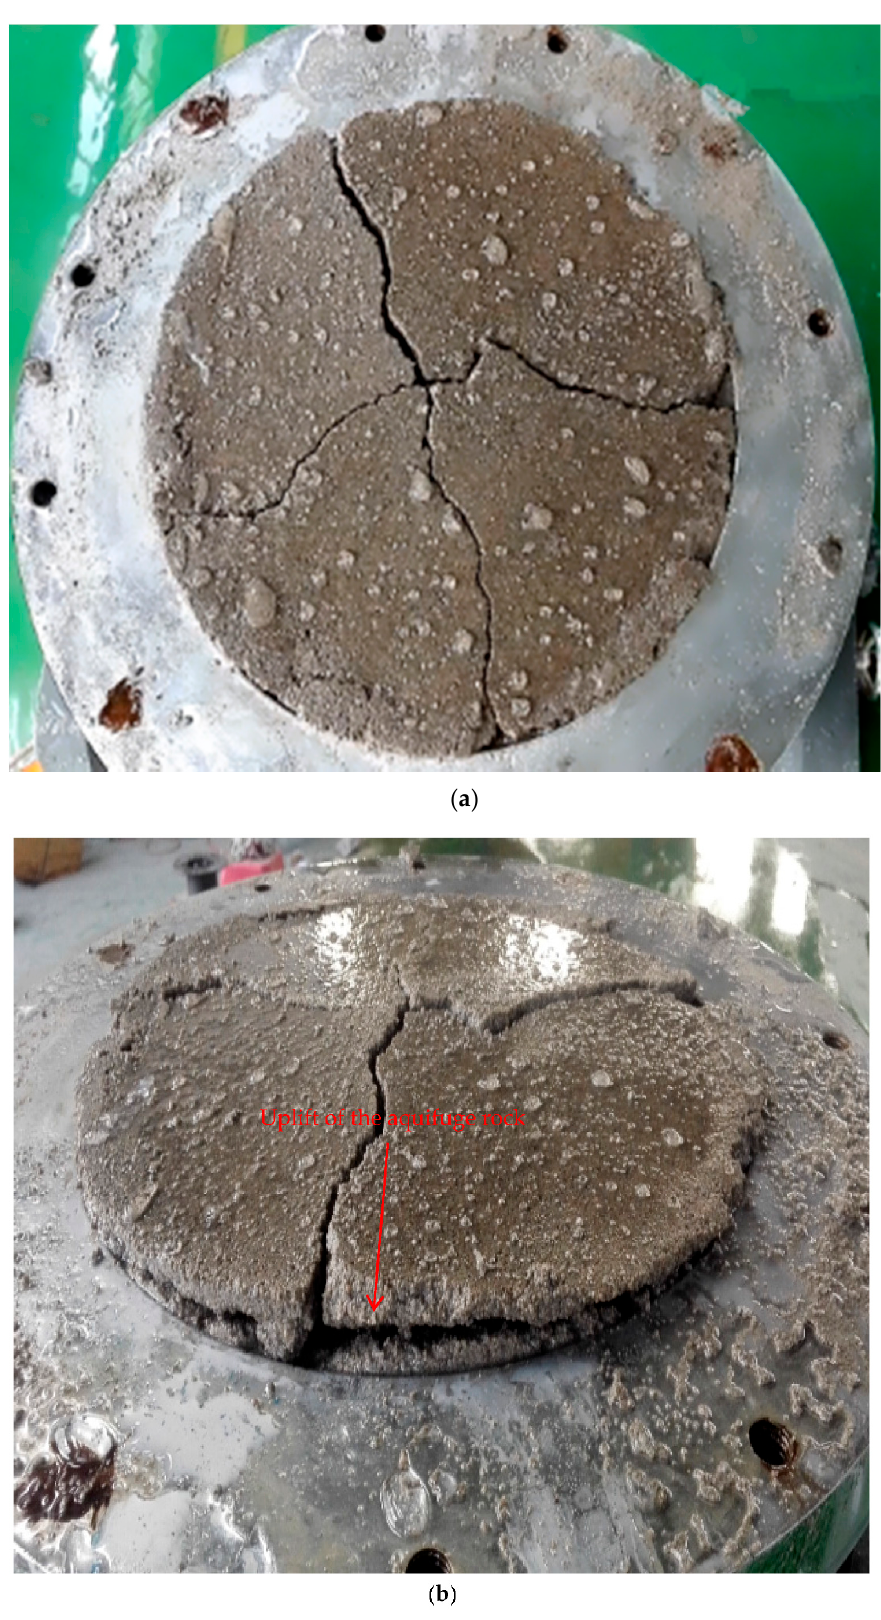
Figure 11. The picture of rock after water inrush at the bottom of arch. ( a ) The water inrush stopped after the water pressure loading system shuts down. ( b ) Uplift of the aquifuge rock.